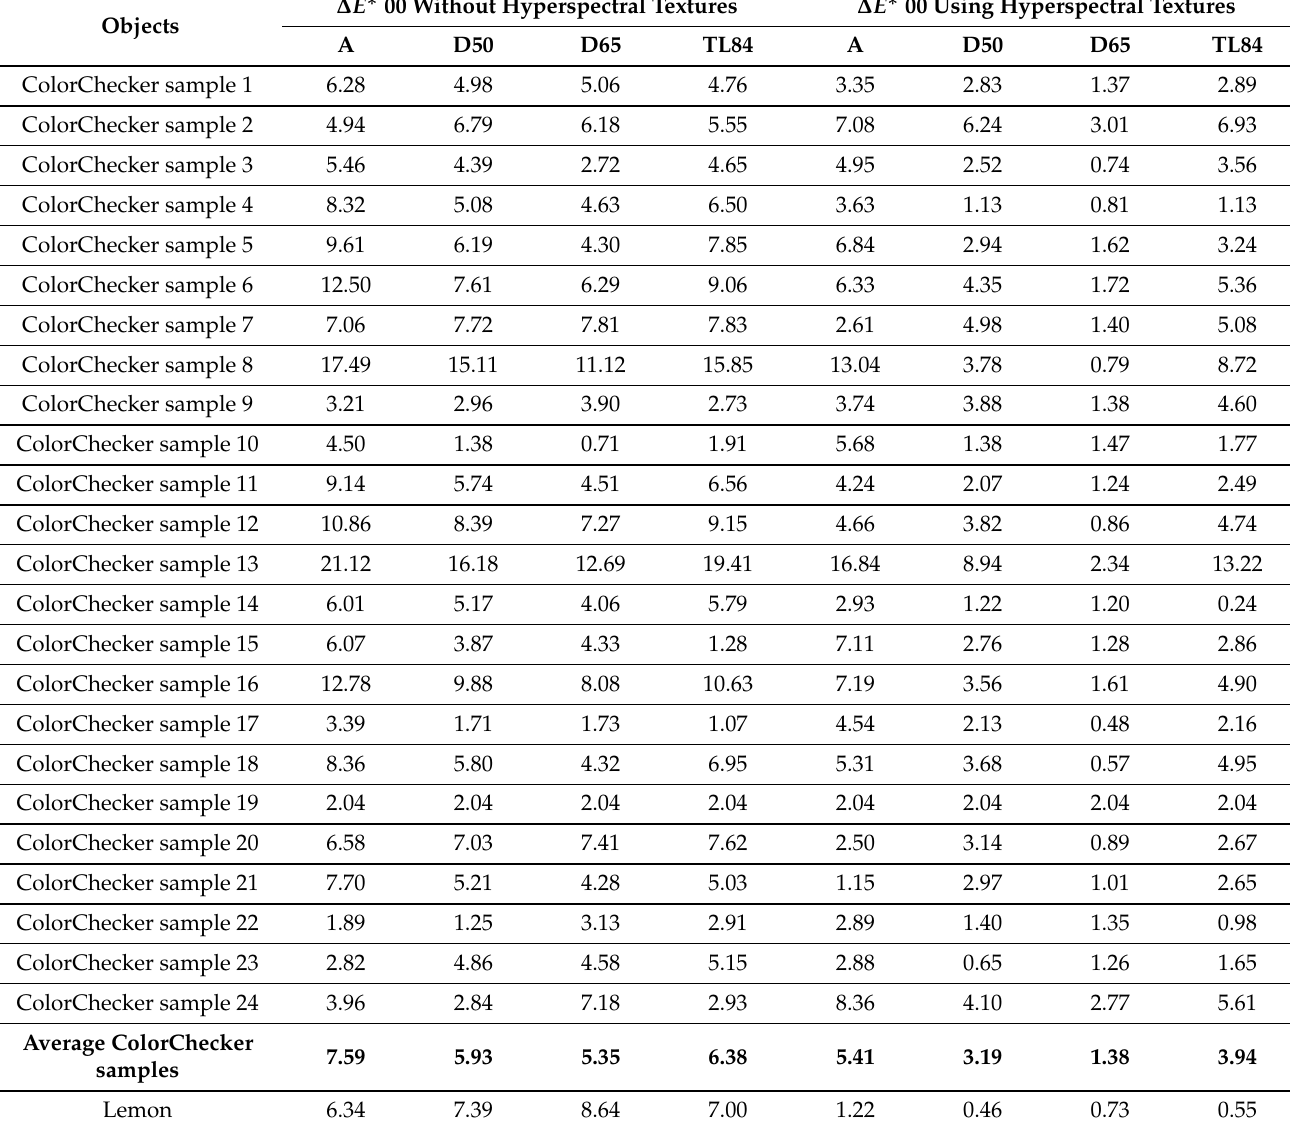
Table 2. Color difference in all objects in the scene under different light sources with and without hyperspectral